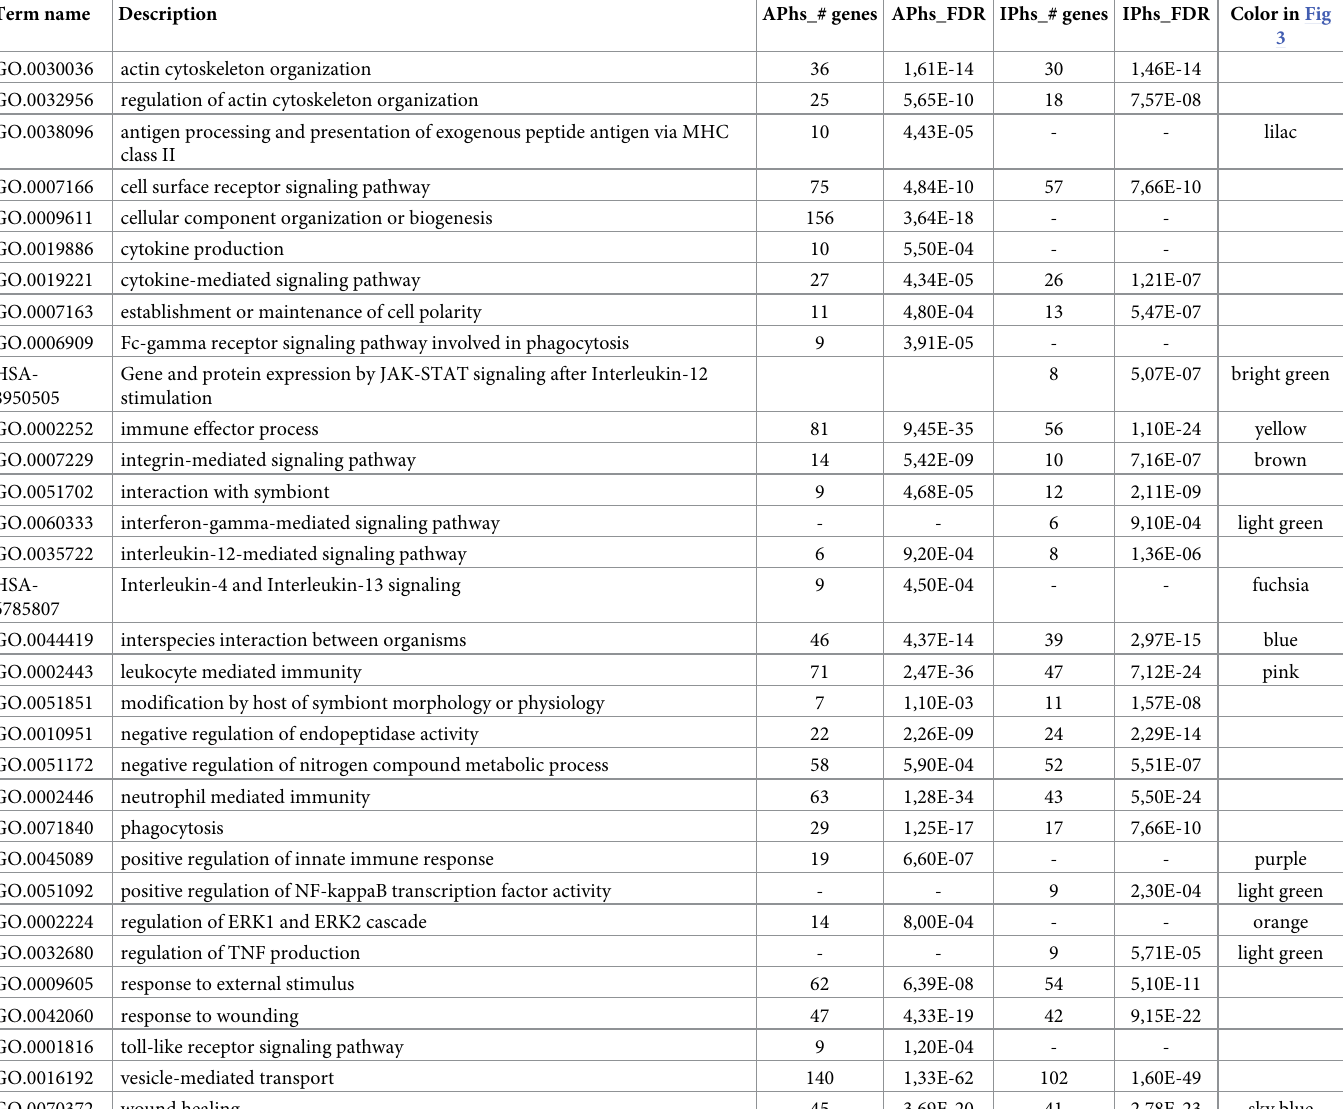
Table 3. A selection of GO Biological Process and Reactome Pathways enriched in APhs and/or IPhs. For each Process or Pathway listed, the number of genes belong- ing to the Term and the false discovery rate (FDR) probability are reported. The colours used in Fig 6 are used to highlight the specific GO terms and are reported in the last